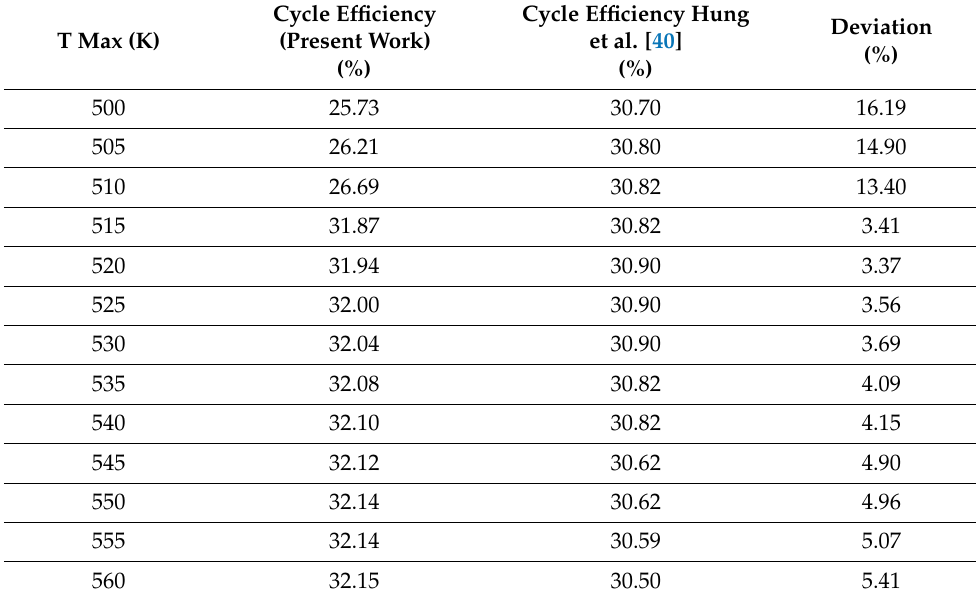
Table 6. Validation of the ORC model using data from Hung et al. [40]. T Max (K)